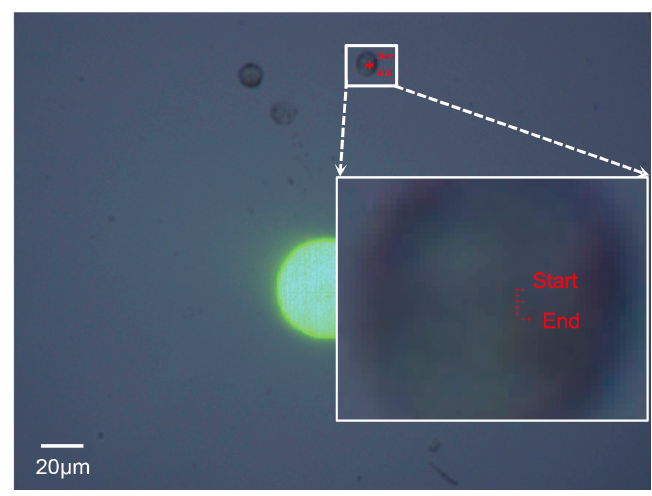
Figure 13. Motion trajectory of the cell of interest.